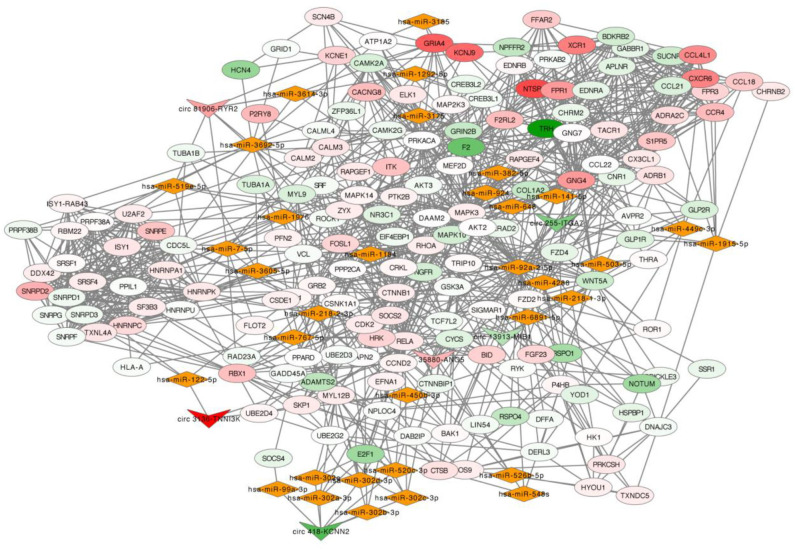
circRNA-miRNA-mRNA network. In this network, inverted triangle represents circRNA, rhombus means miRNA and ellipse means mRNA. The color intensity of circRNAs and mRNAs was related with the fold change of single gene in RNA-seq. Upregulation was visualized in red and downregulation in green.